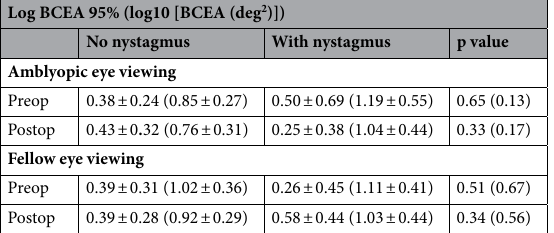
Table 4. Bivariate contour ellipse analysis (log10 [BCEA (deg 2 )]) in viewing eye and non-viewing eye (non- viewing eye in parenthesis) of subjects without and with nystagmus, before and after strabismus